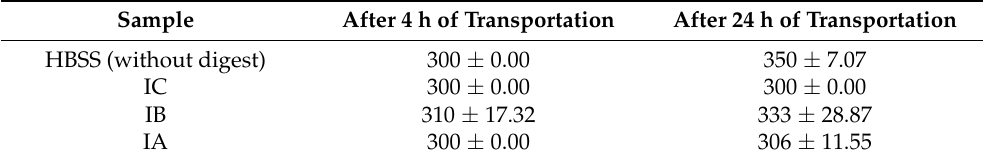
Table 4. TEER ( Ω cm 2 ) values of Caco-2 cells were measured at 0 h and after 4 h and 24 h of incuba- tion.